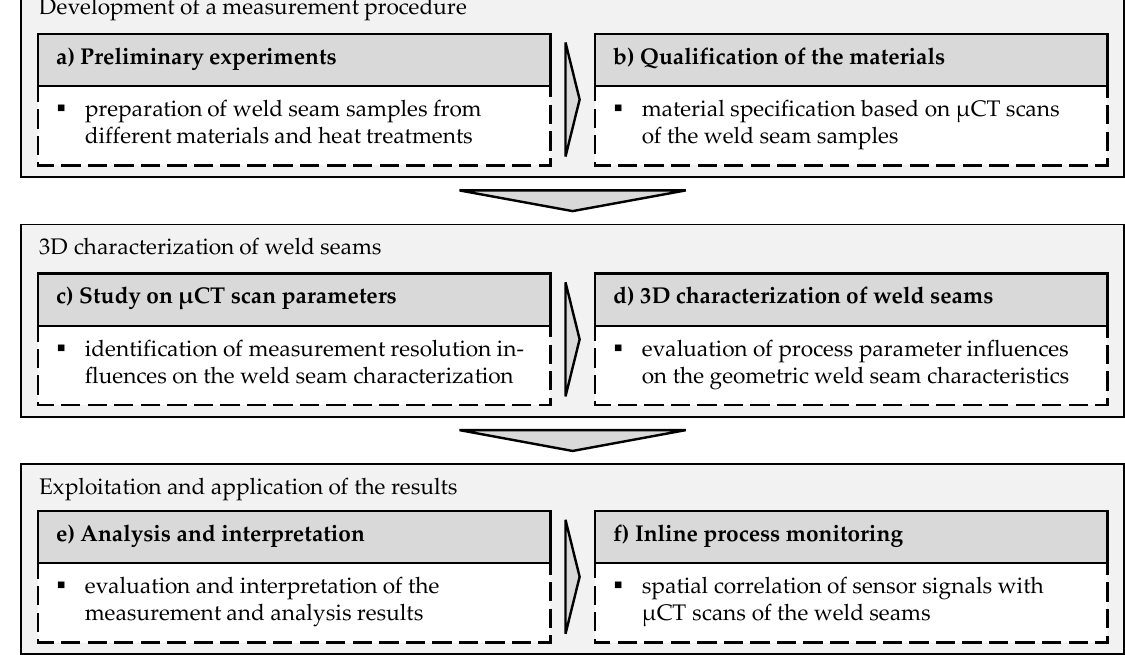
Figure 4. Methodological approach for the development of a 3D weld seam characterization method to obtain reliable reference data with temporal correlation to inline process monitoring data.